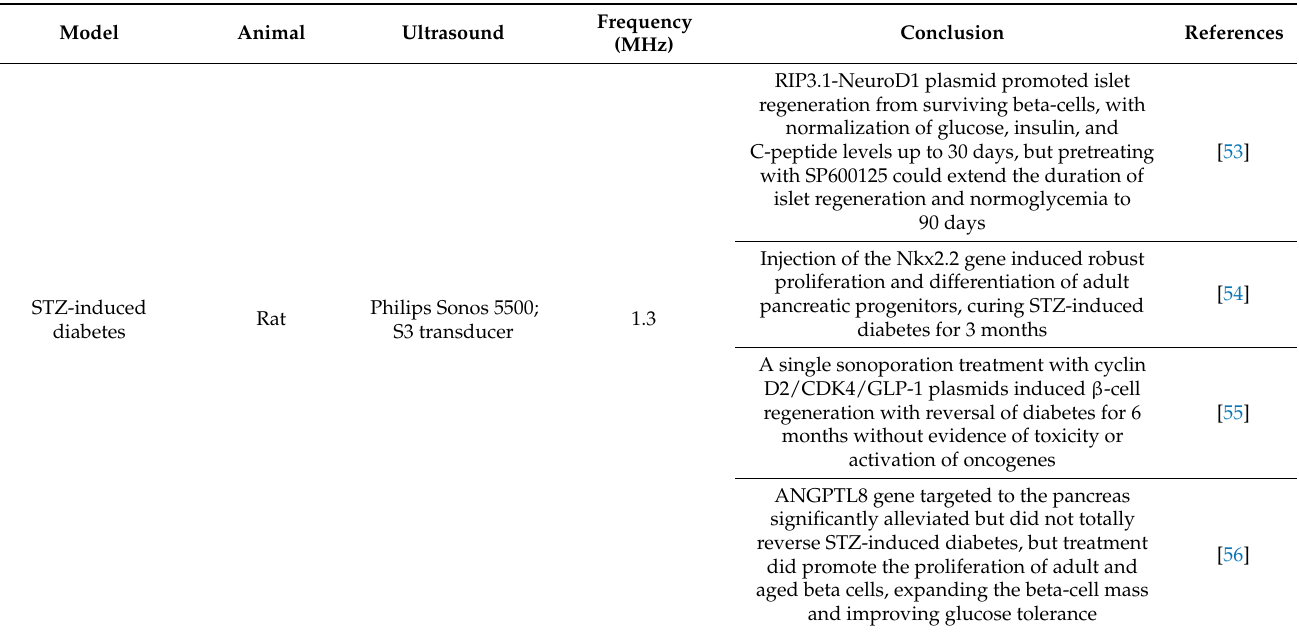
Table 6. The use of sonoporation as a therapy for